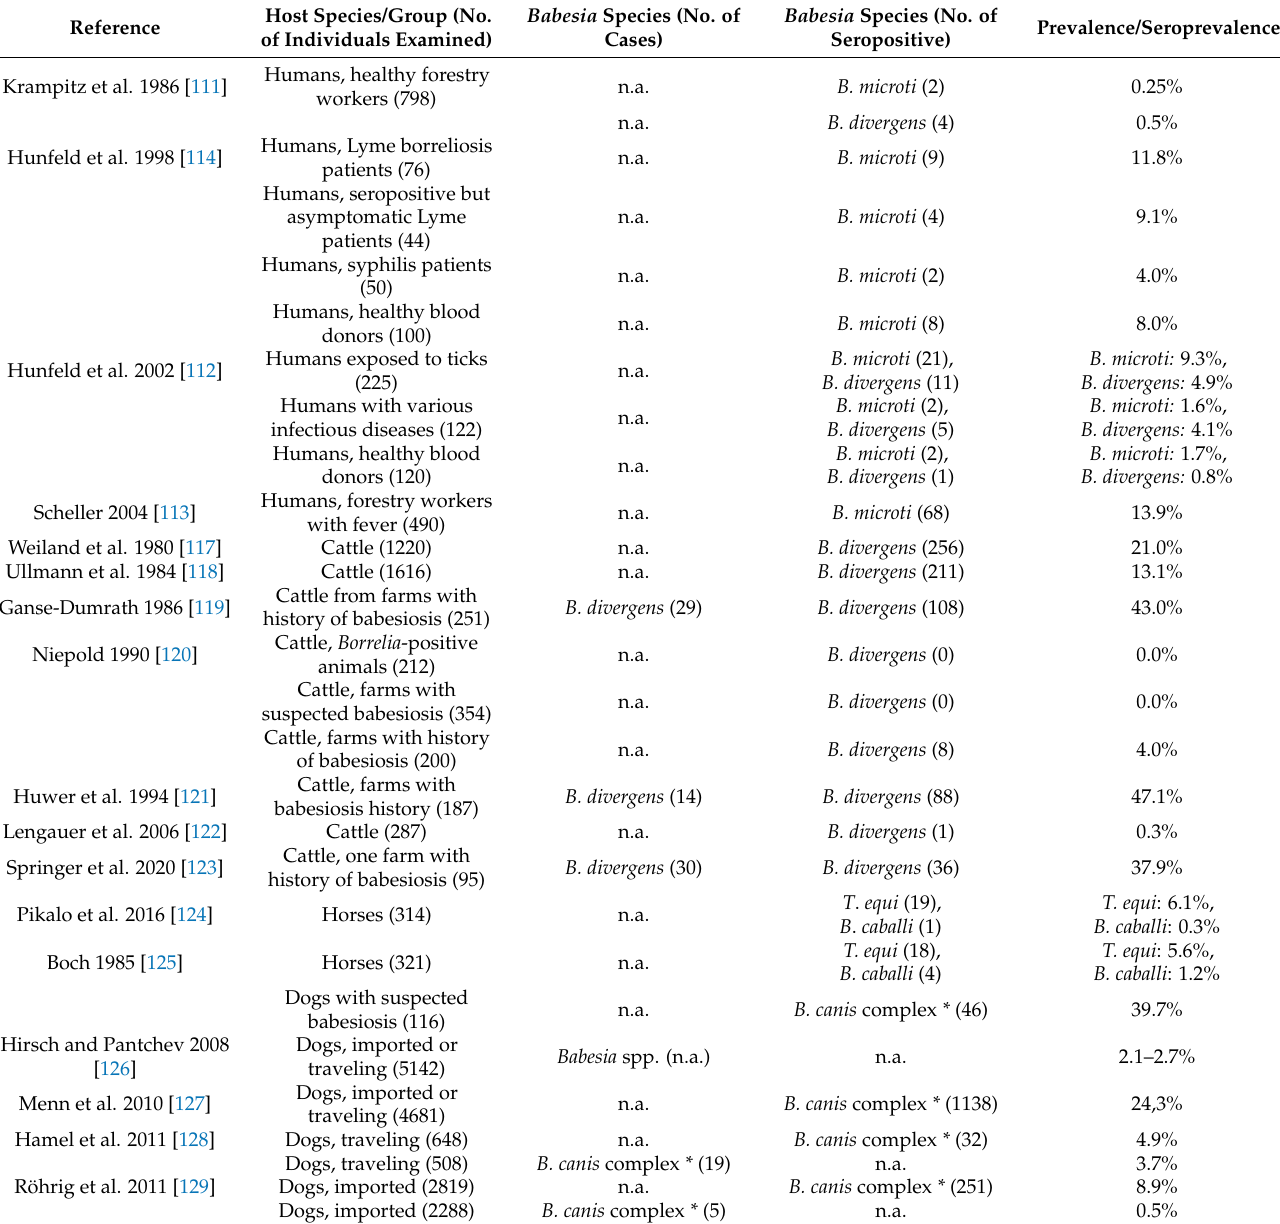
Table 1. Summary of studies reporting the (sero-)prevalence of Babesia spp. in